Question: According to the figure, is the described quantity increasing or decreasing?
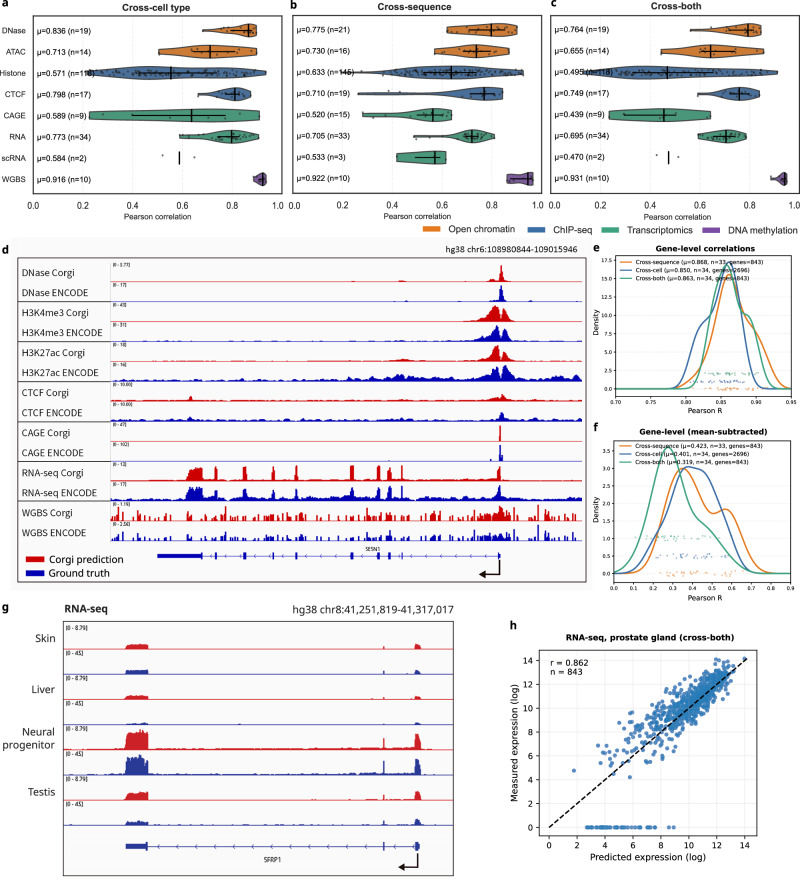
Answer: increasing